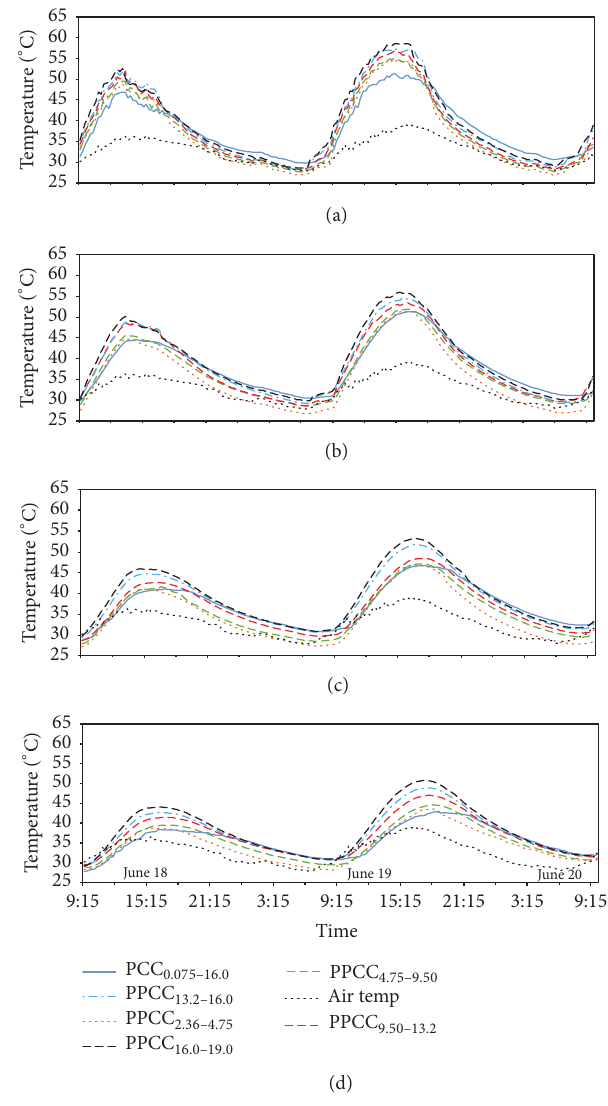
Figure 5: Temperature values of concrete at different depths: (a) 0 cm; (b) − 5cm; (c) − 10cm; and (d) −